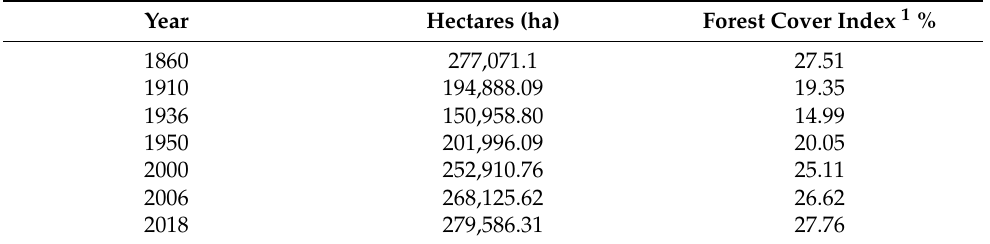
Figure 4. Forest cover map for years of analysis. Table 3. Area in hectares of forests and percentage of total area of Basilicata region (forest cover index).